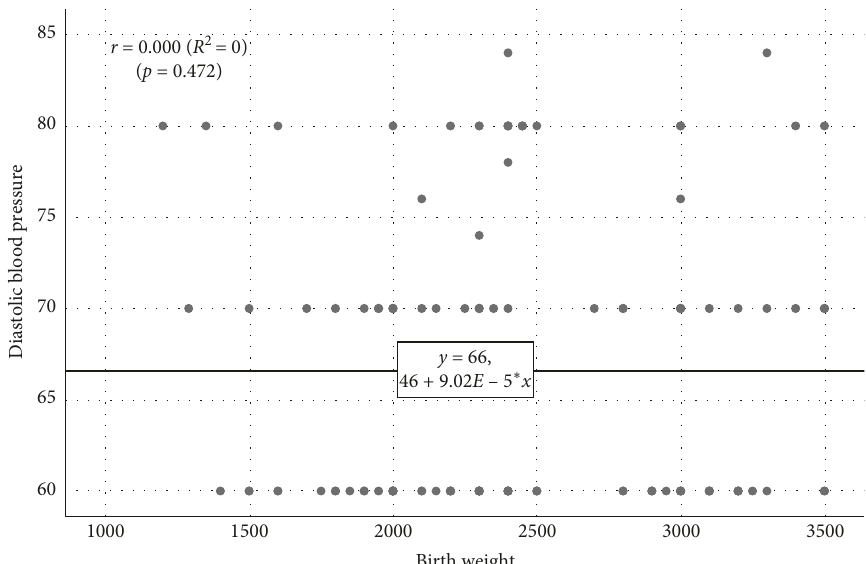
Figure 6: Scatterplot diagram for the association between birth weight and diastolic blood pressure.